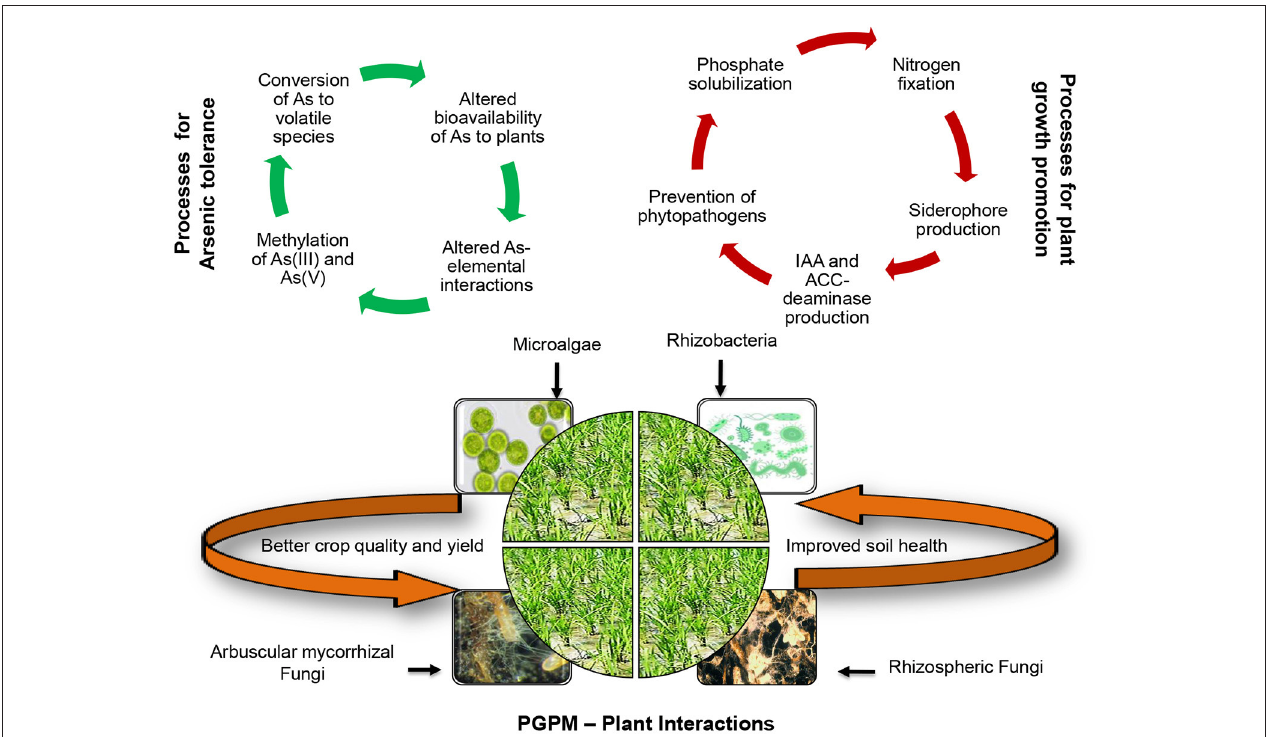
FIGURE 2 | Schematic representation of mechanisms of growth promotion and arsenic tolerance imparted to plants by plant growth promoting microorganisms (PGPMs).